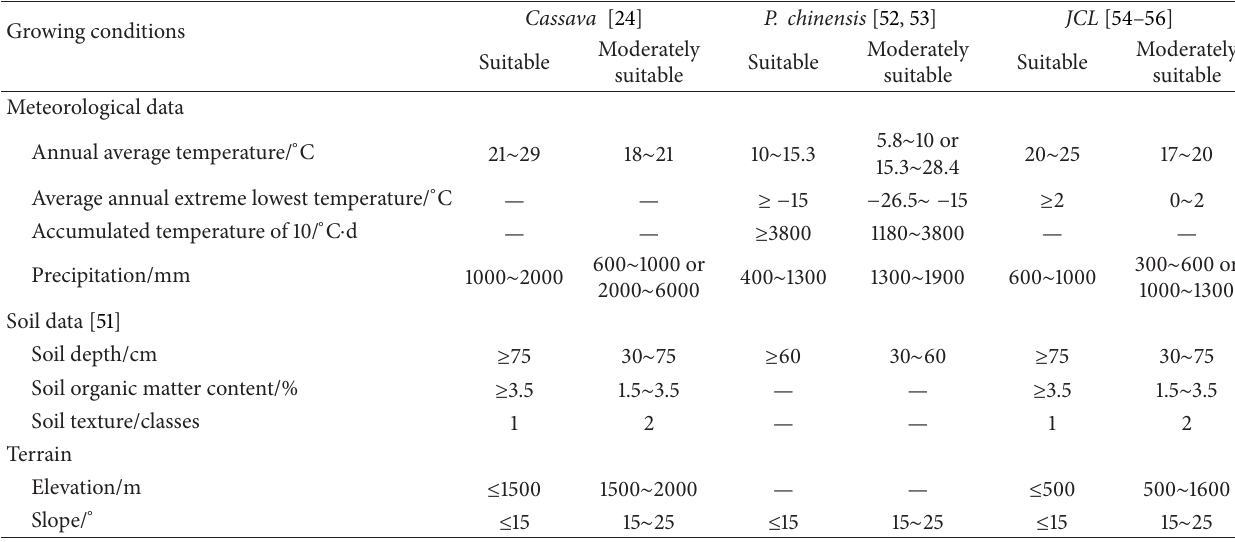
Table 2: Growing conditions of energy